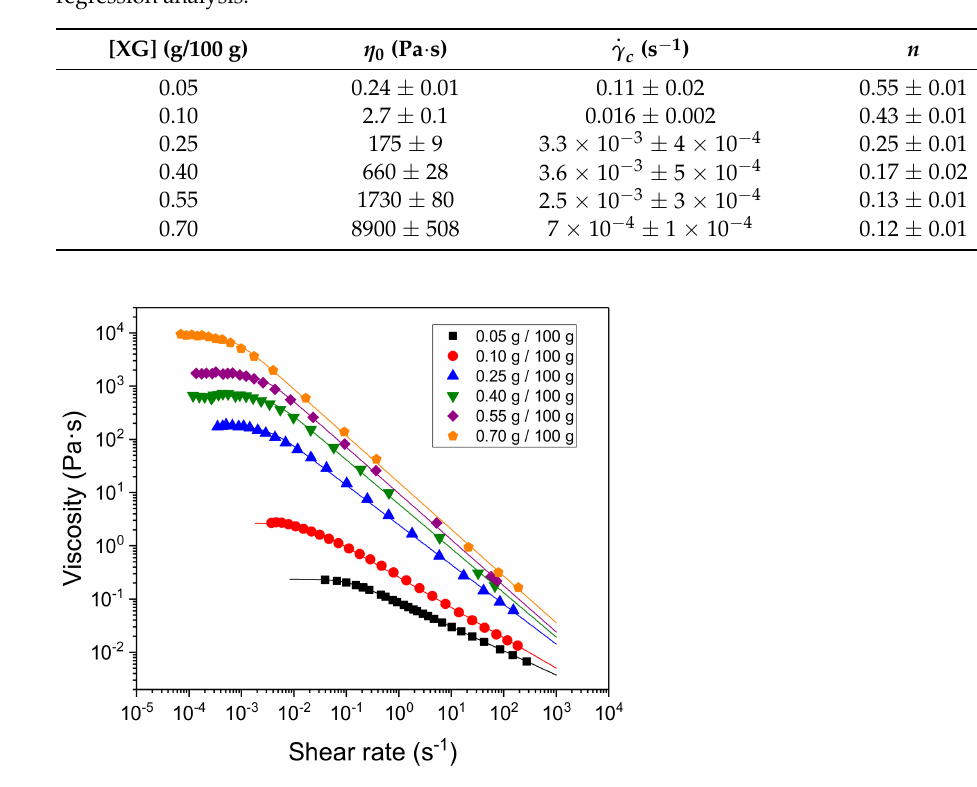
Figure 7. Steady state viscosity as a function of shear rate for the fennel oil nanoemulsion with different AP xanthan gum concentrations at 20 ◦ C. The lines are the best fit to the Carreau model, whose parameters are given in Table 2. Data shown are the average value of three replicates with a standard deviation for all the experiments lower than